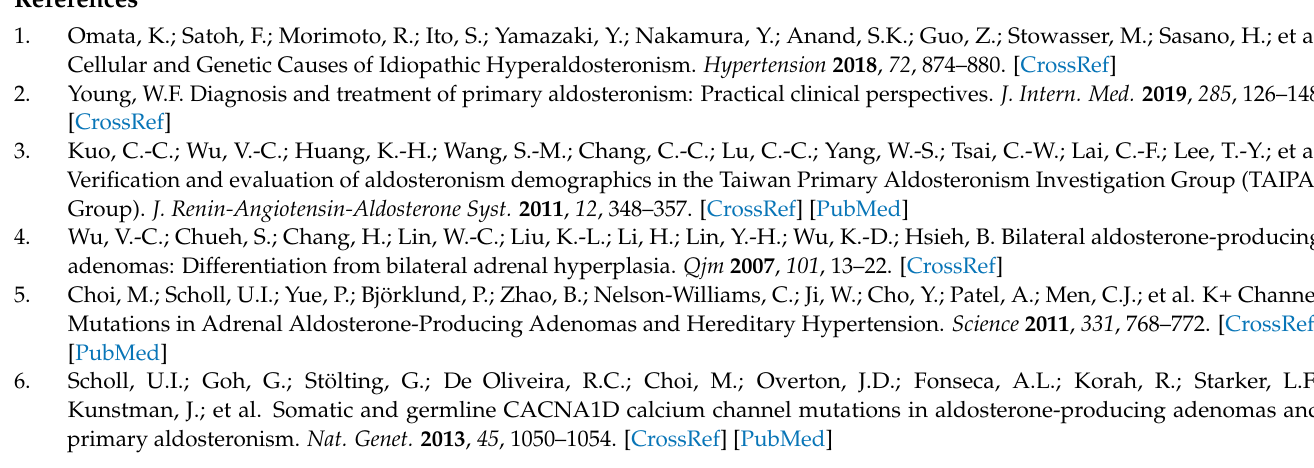
Figure S2. Uncropped Western Blot images from Figure 3 in the main text, Table S1. Primers used for Sanger